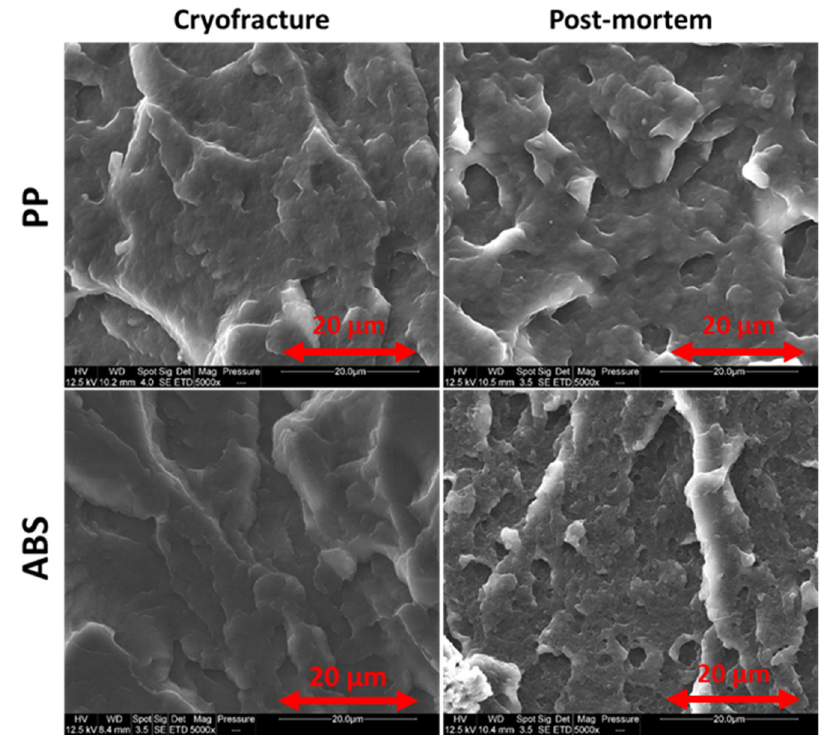
Figure 11. Comparison of cavitation phenomena within ABS and PP—SEM pictures on cryofractured dogbones and post-mortem samples from tensile tests at 10 mm/min.